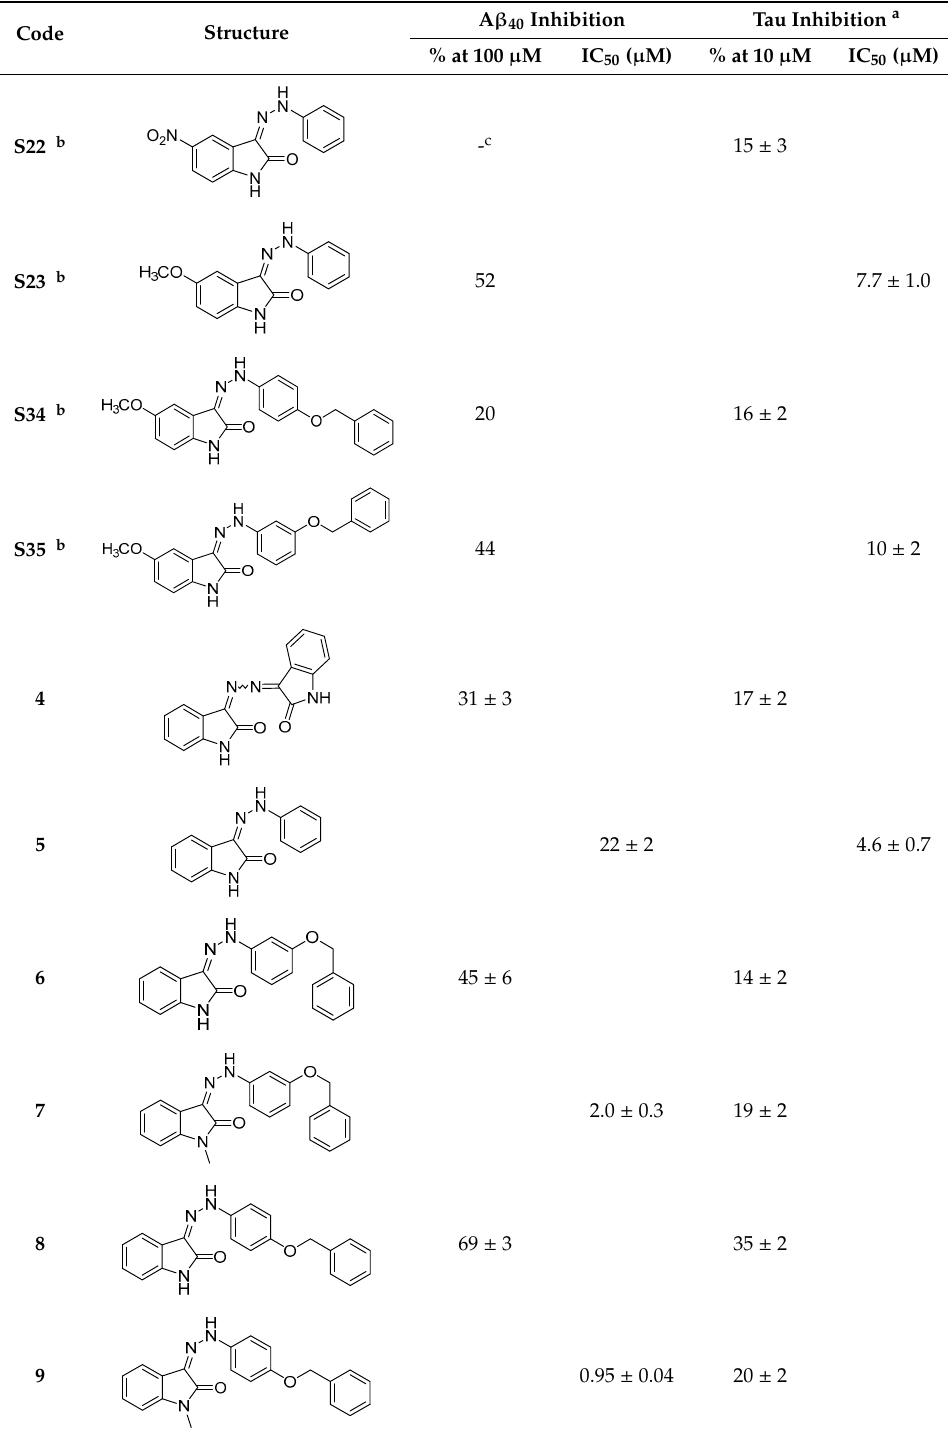
Table 5. Inhibition of β -amyloid and tau aggregation.